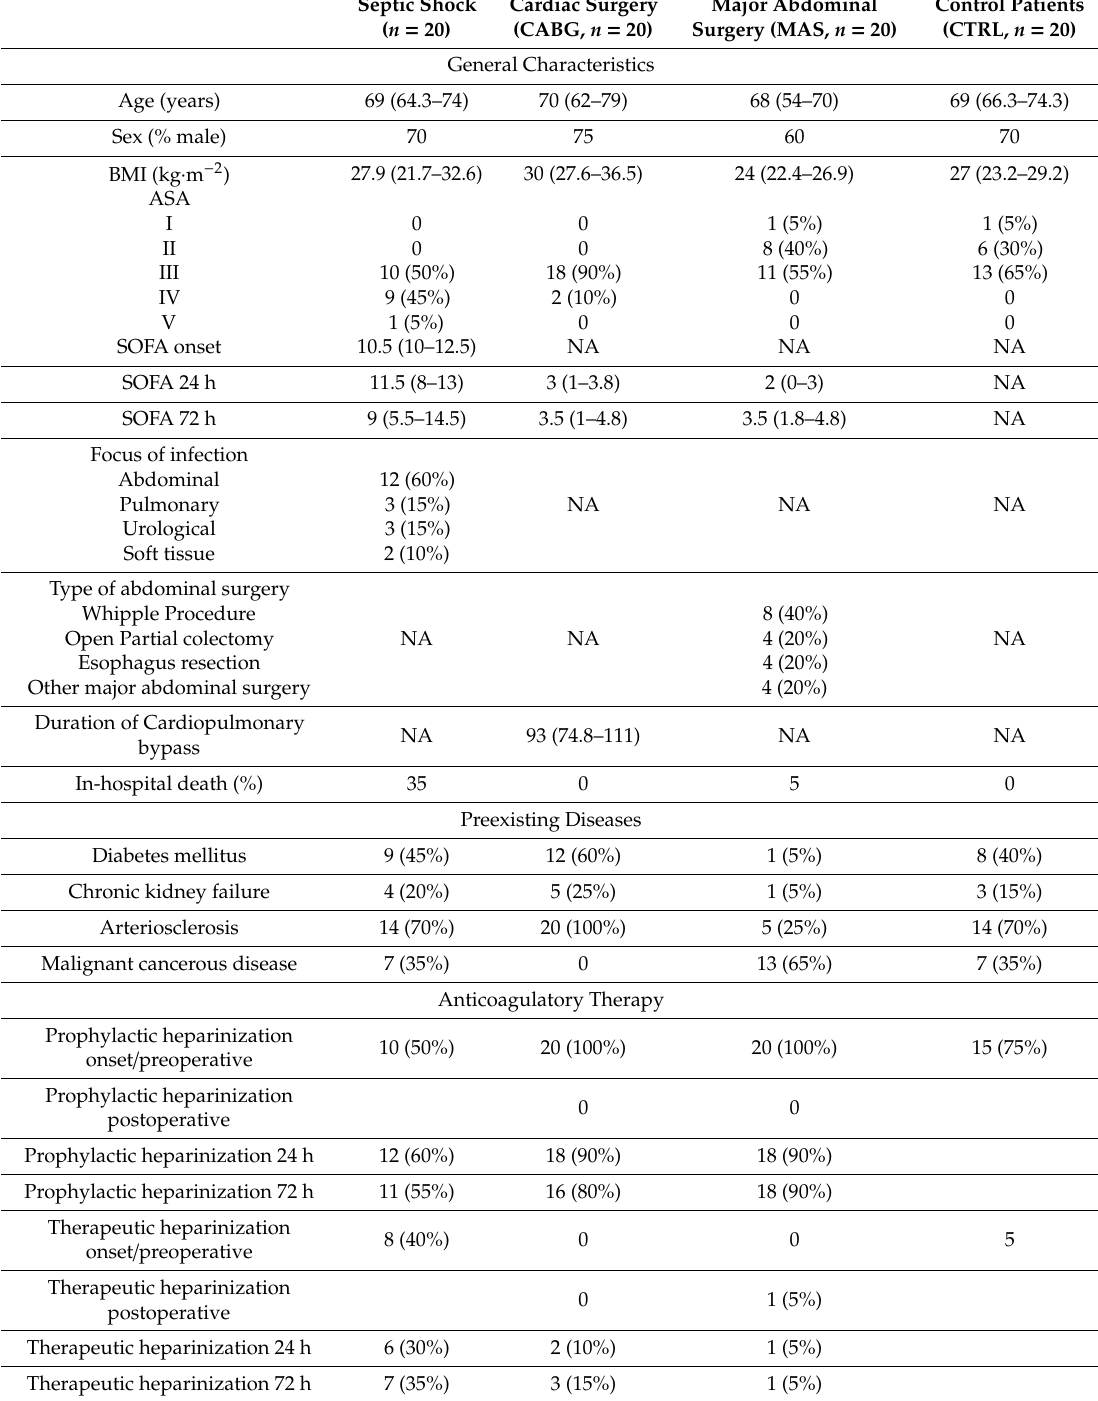
Table 1. Description of the study